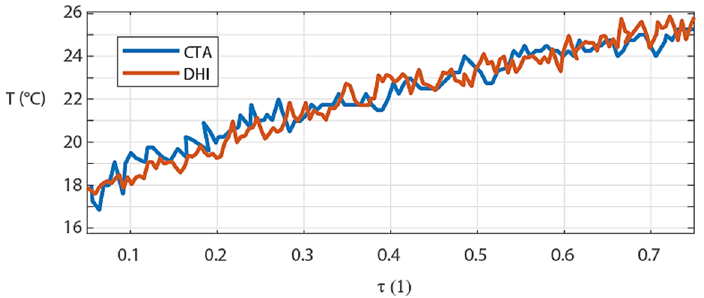
Figure 11. Comparison of DHI and CTA within one representative point within the measured area.